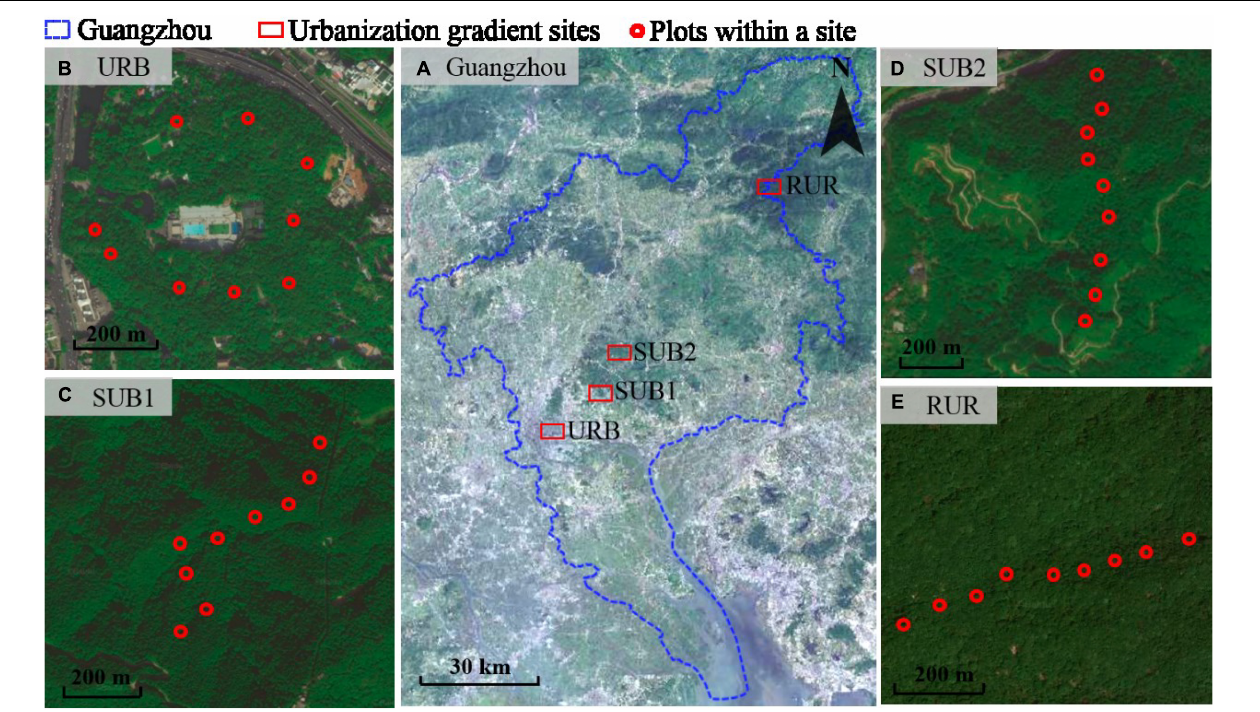
FIGURE 1 | (A) The site location in Guangzhou City along an urbanization gradient. (B–E) The locations of nine plots within each site. The urbanization gradient sites are urban (URB), suburban 1 (SUB1), suburban 2 (SUB2), and rural (RUR)